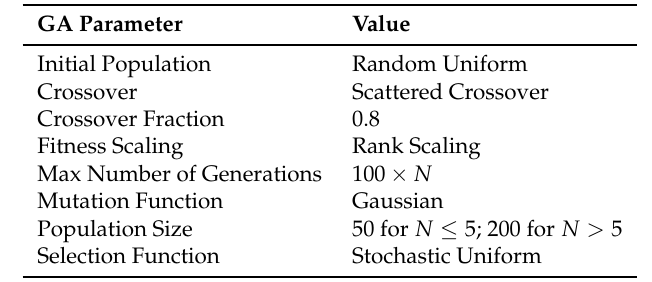
Table 2. Genetic algorithm (GA) options for atomic energy consumption scheduling for cost and PAR minimization.